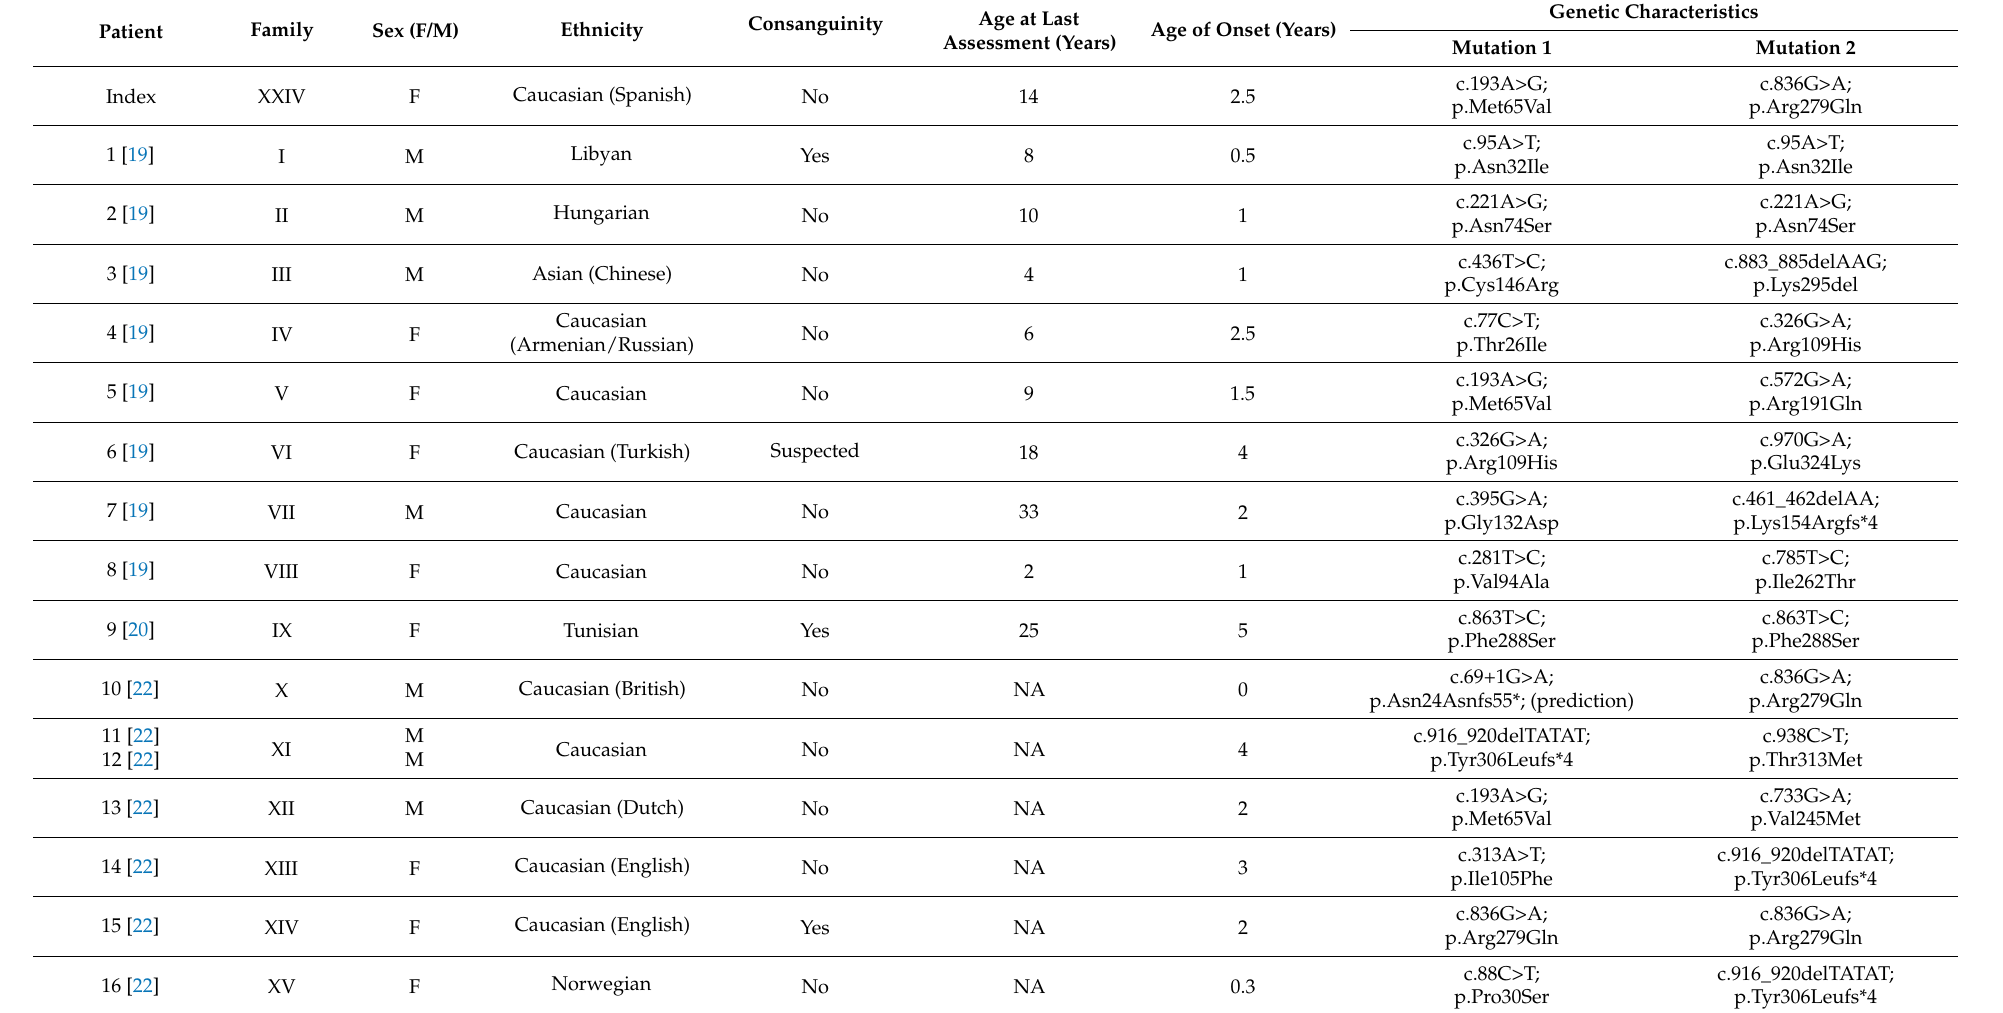
Table 1. Demographic and genetic characteristics of our patient and reported patients with POLR1C